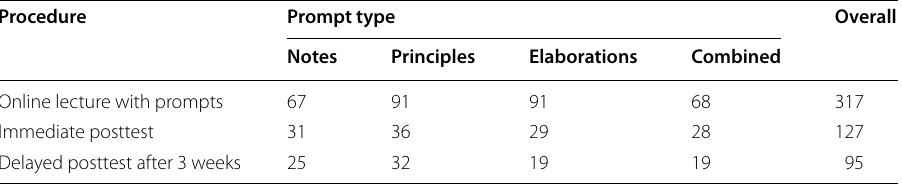
Table 1 Procedure, conditions (prompt types), and number of participants Procedure